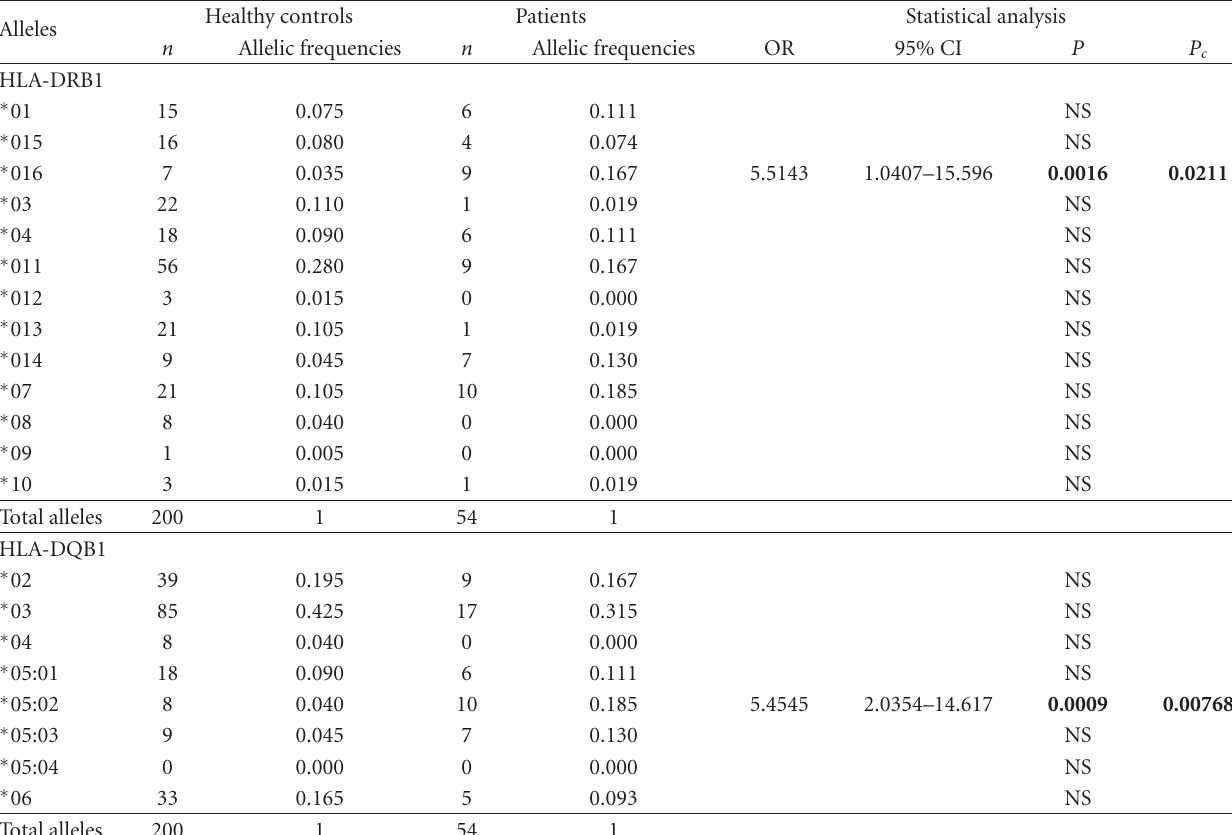
Table 2: HLA class II allele frequency analysis in the LOAb-MG patients subgroup.